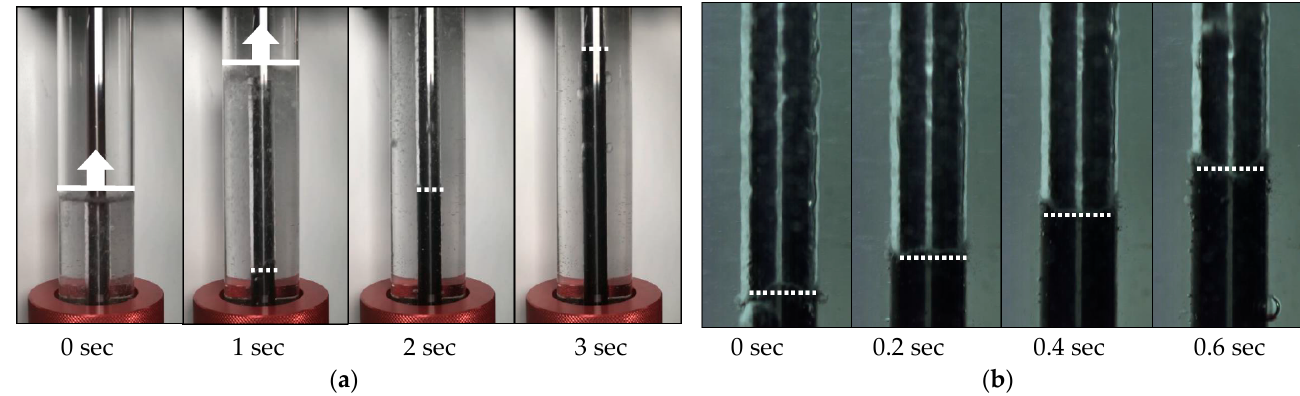
Figure 8. Pictures of the Zr cladding quenching at Tw = 800 °C, T sub = 50 °C and Vc = 0.05 m/s using; ( a ) digital camera; ( b ) high-speed camera.